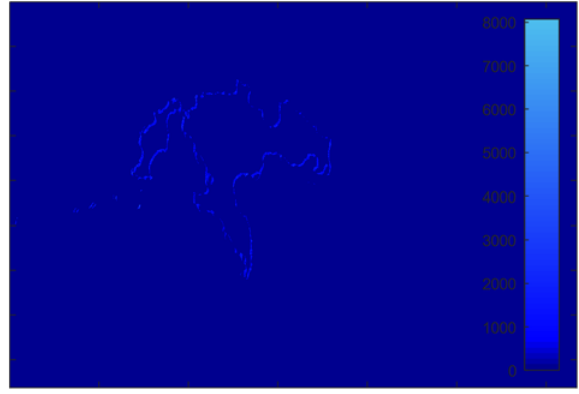
Figure 11. The detection error area in SAR image (absolute value of complex image). Table 2. Quantitative Evaluation of our method.